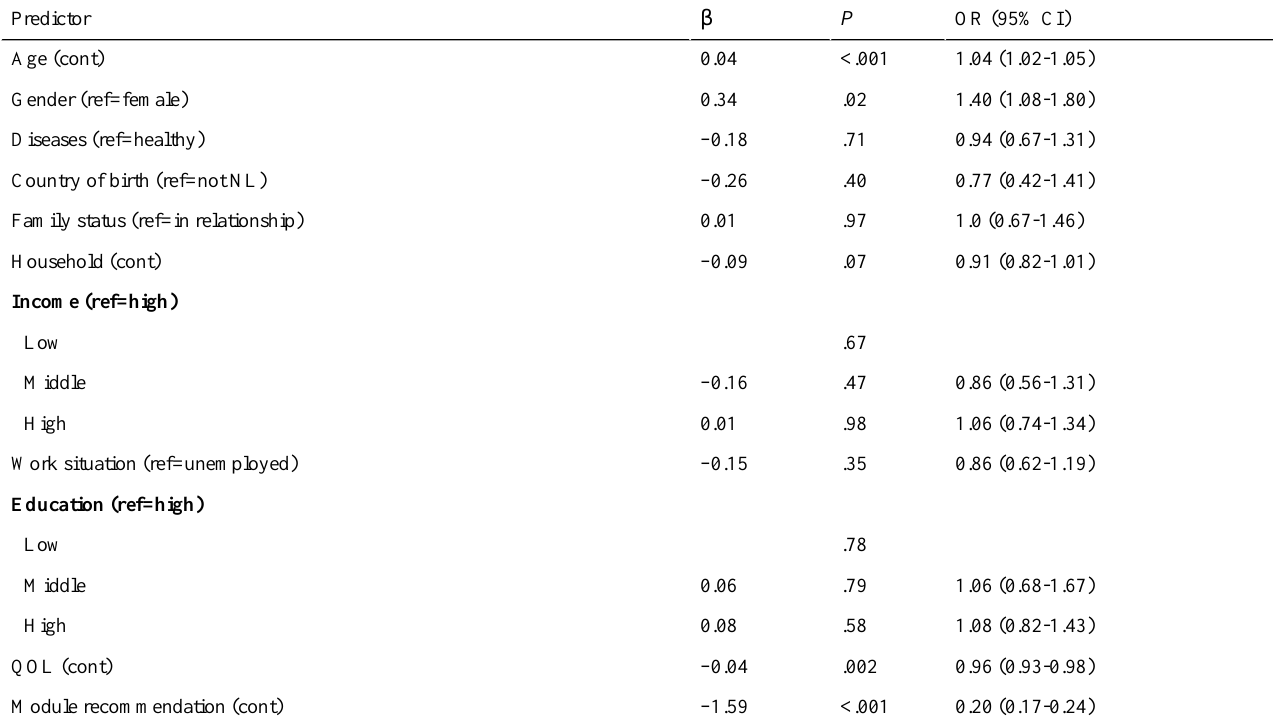
Table 3. Logistic regression results for the relationship between socioeconomic variables, personal characteristics, and following the intervention recommendation within the complete sample